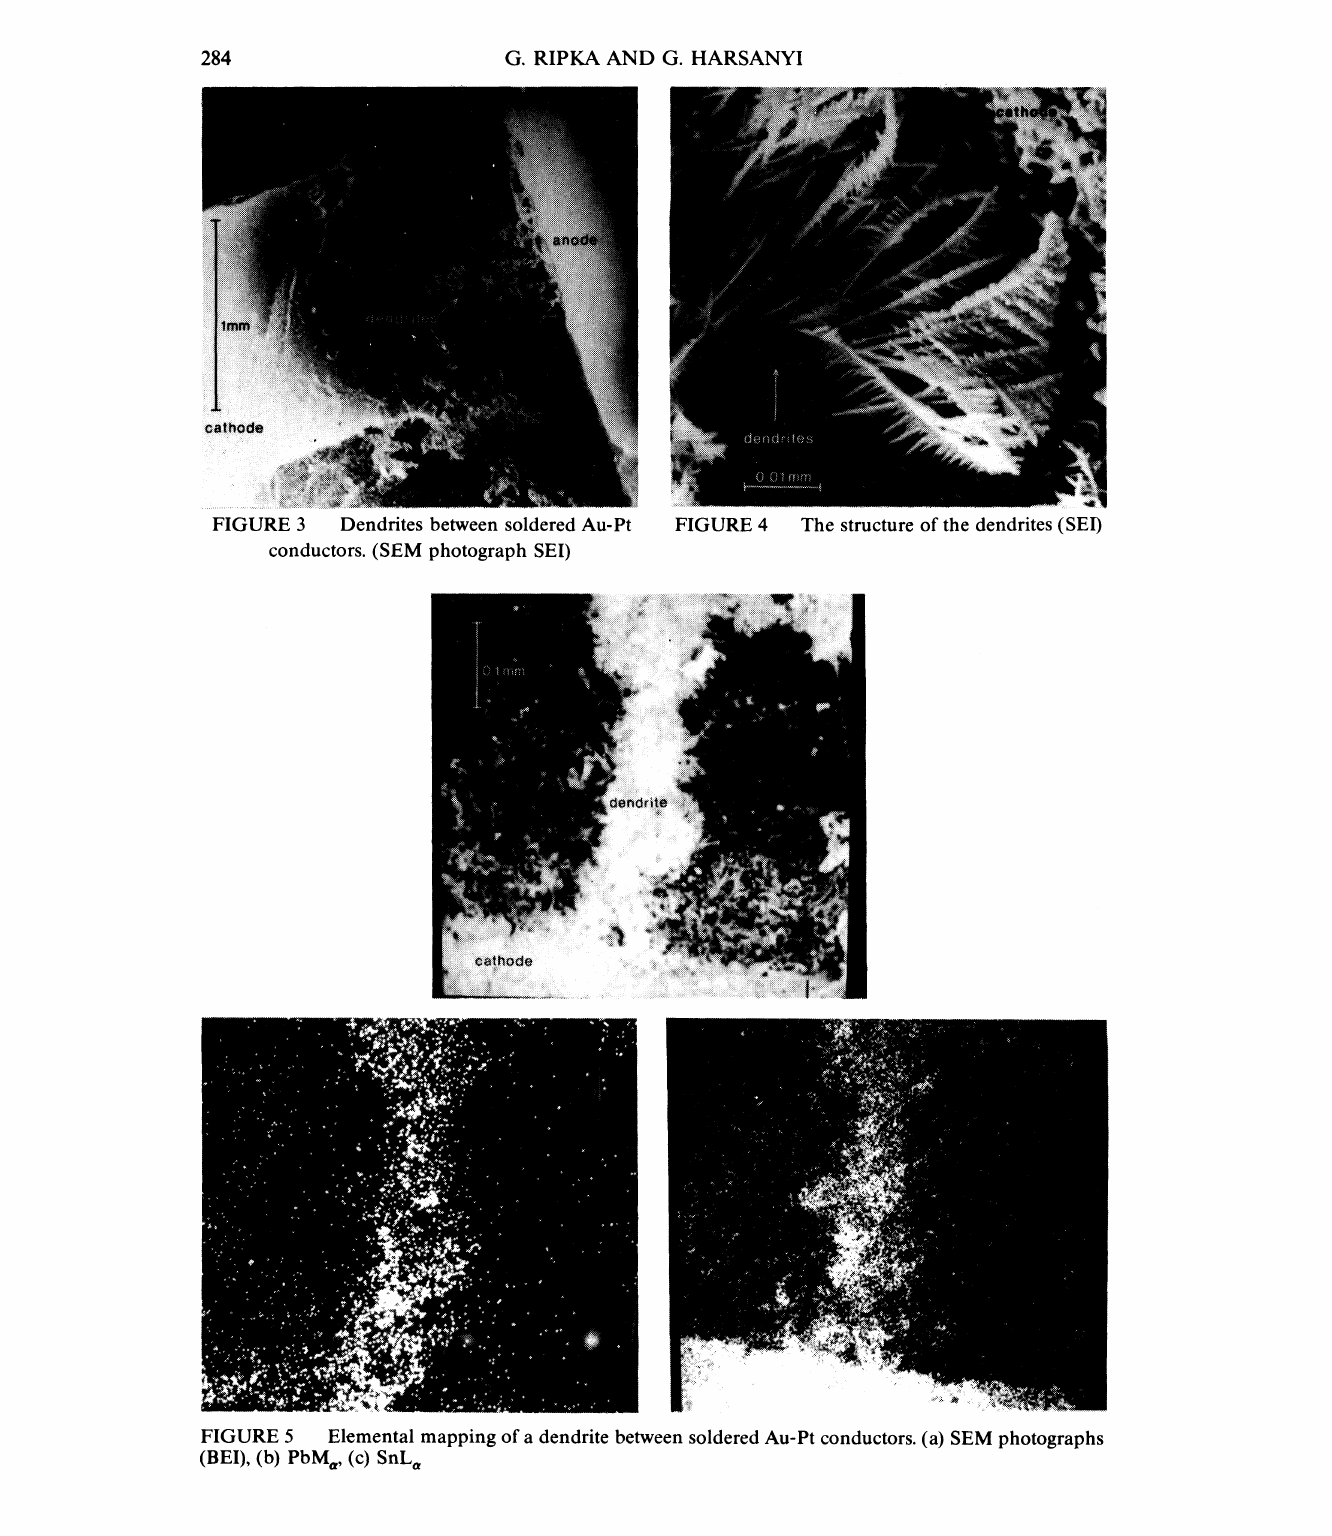
Elemental mapping of a dendrite between soldered Au-Pt conductors. (a) SEM photographs (BEI), (b) PbM (c) a,